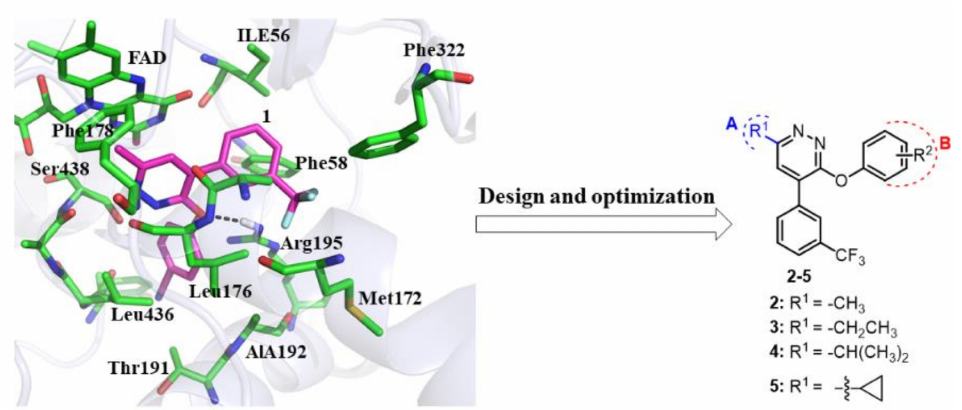
Figure 2. The discovery process of compounds 2 – 5 . The simulated binding mode of compound 1 with Synechococcus PDS is shown in cartoon mode, the structure of 1 is shown in the magenta sticks, and the key residues in the active site are shown in the green